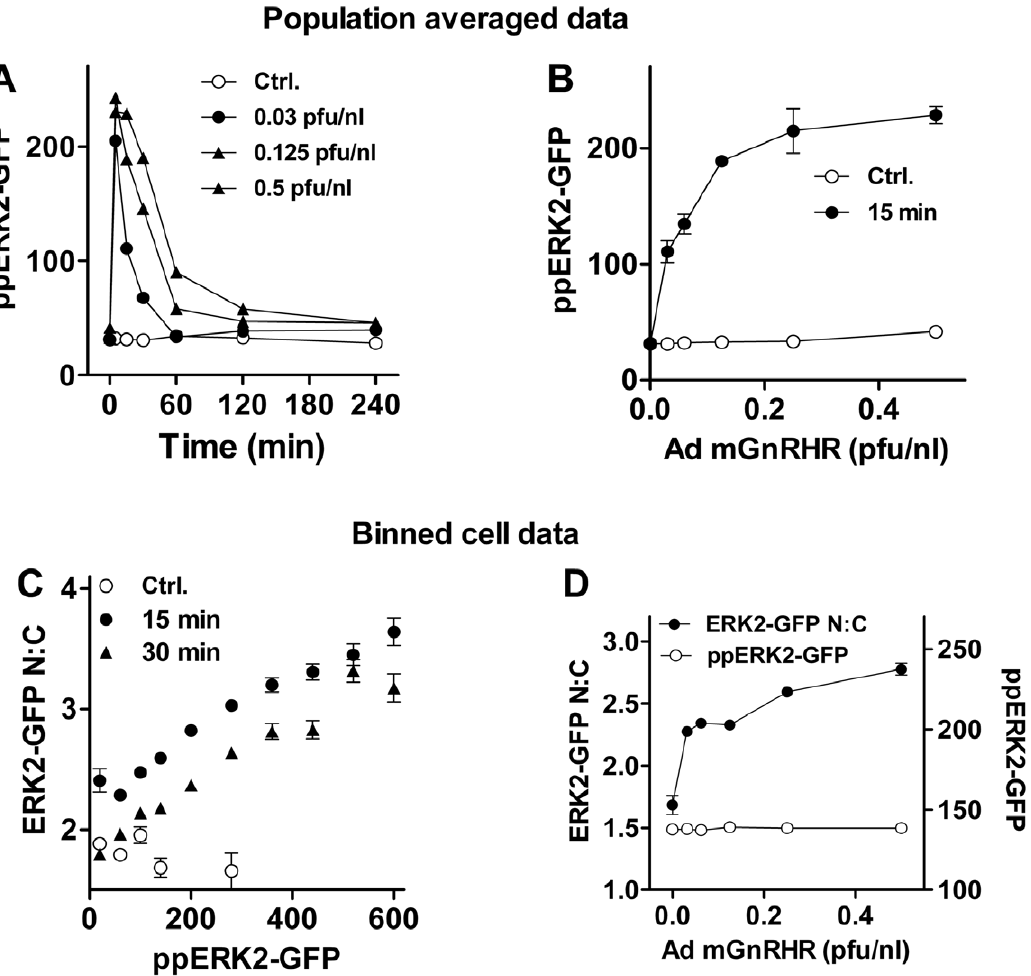
Figure 10. Relevance of GnRHR expression level for TEY phosphorylation unattributable nuclear localization of ERK2-GFP. For panels A and B, HeLa cells transfected with ERK siRNAs were transduced with Ad ERK2-GFP (WT) and with Ad mGnRHR at varied titre (0, 0.03, 0.06, 0.125, 0.25 or 0.5 pfu/nl) in order to vary GnRHR number. They were then stimulated for the indicated period before being fixed and stained for ppERK2-GFP and DAPI. Imaging and analysis of single cells was carried out as described in Methods. The plots show cell population averaged ppERK2-GFP levels for cells stimulated with 100 nM GnRH plotted against time (A), or for cells stimulated 15 min with 0 (Ctrl.) or 100 nM GnRH, plotted against Ad mGnRHR titre (B). These data are from a single experiment with duplicate wells, and are representative of those from 2